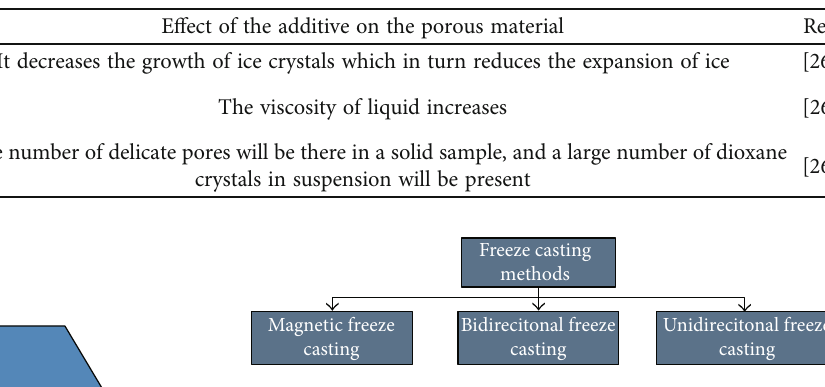
Table 2: E ff ect of the additive on the porous material.